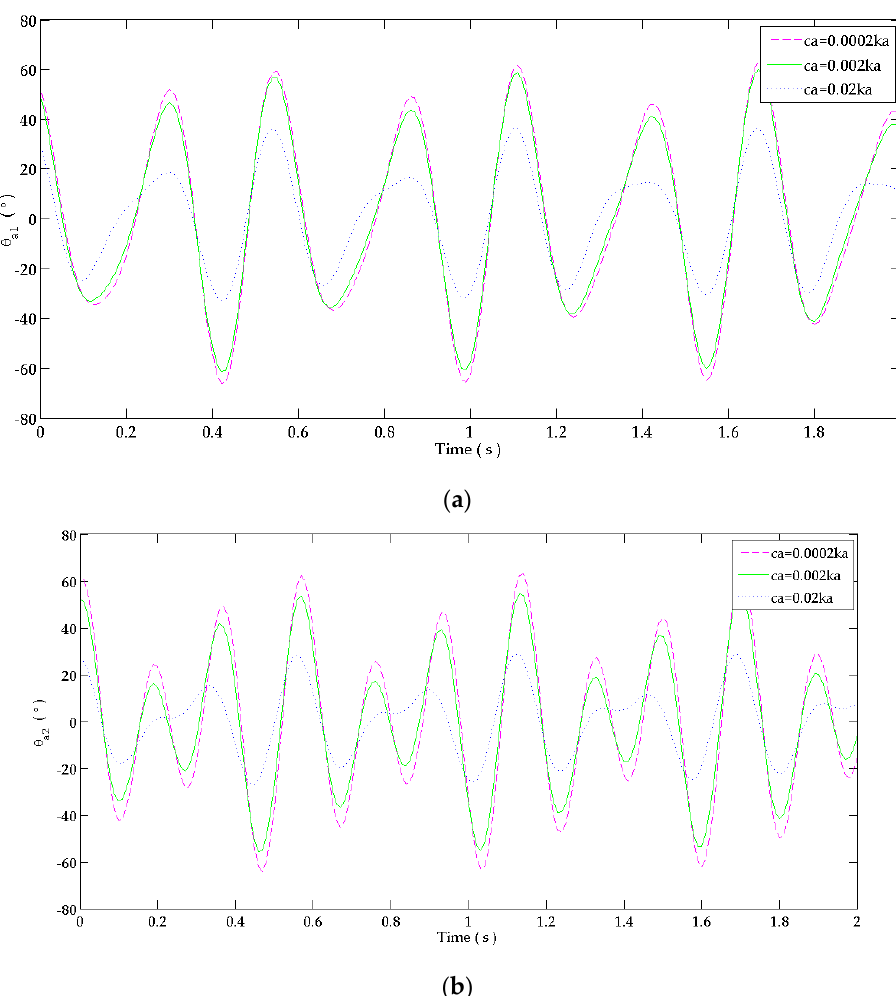
Figure 11. Response in time domain at: ( a ) “absorber 1”; ( b ) “absorber 2” joints. The fluctuation of each absorber when it is attached alone to the forearm for different beams’ damping coefficients.